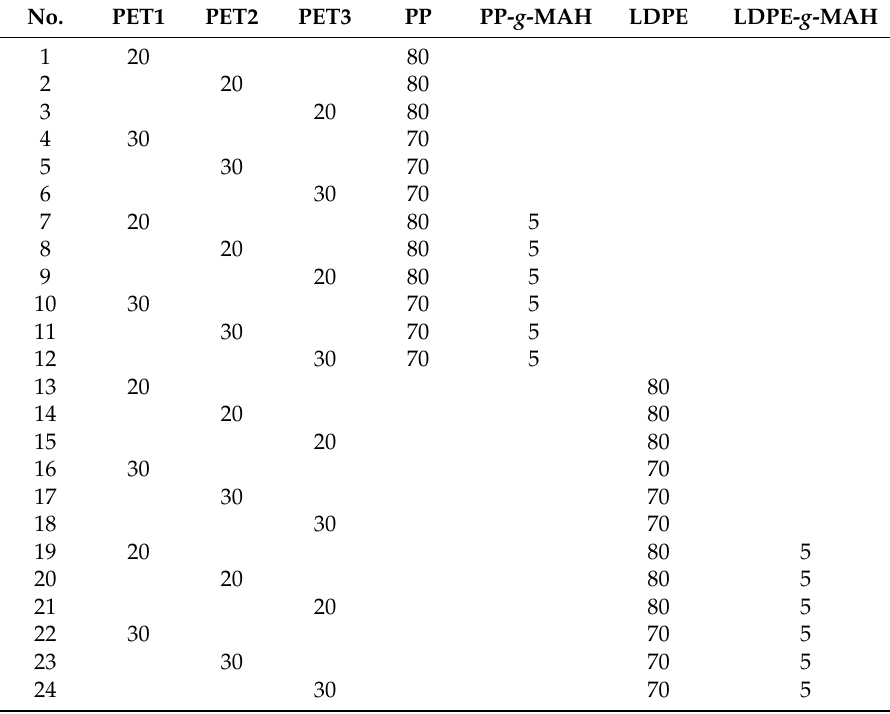
Table 2. The weight ratio of the components in the polymer